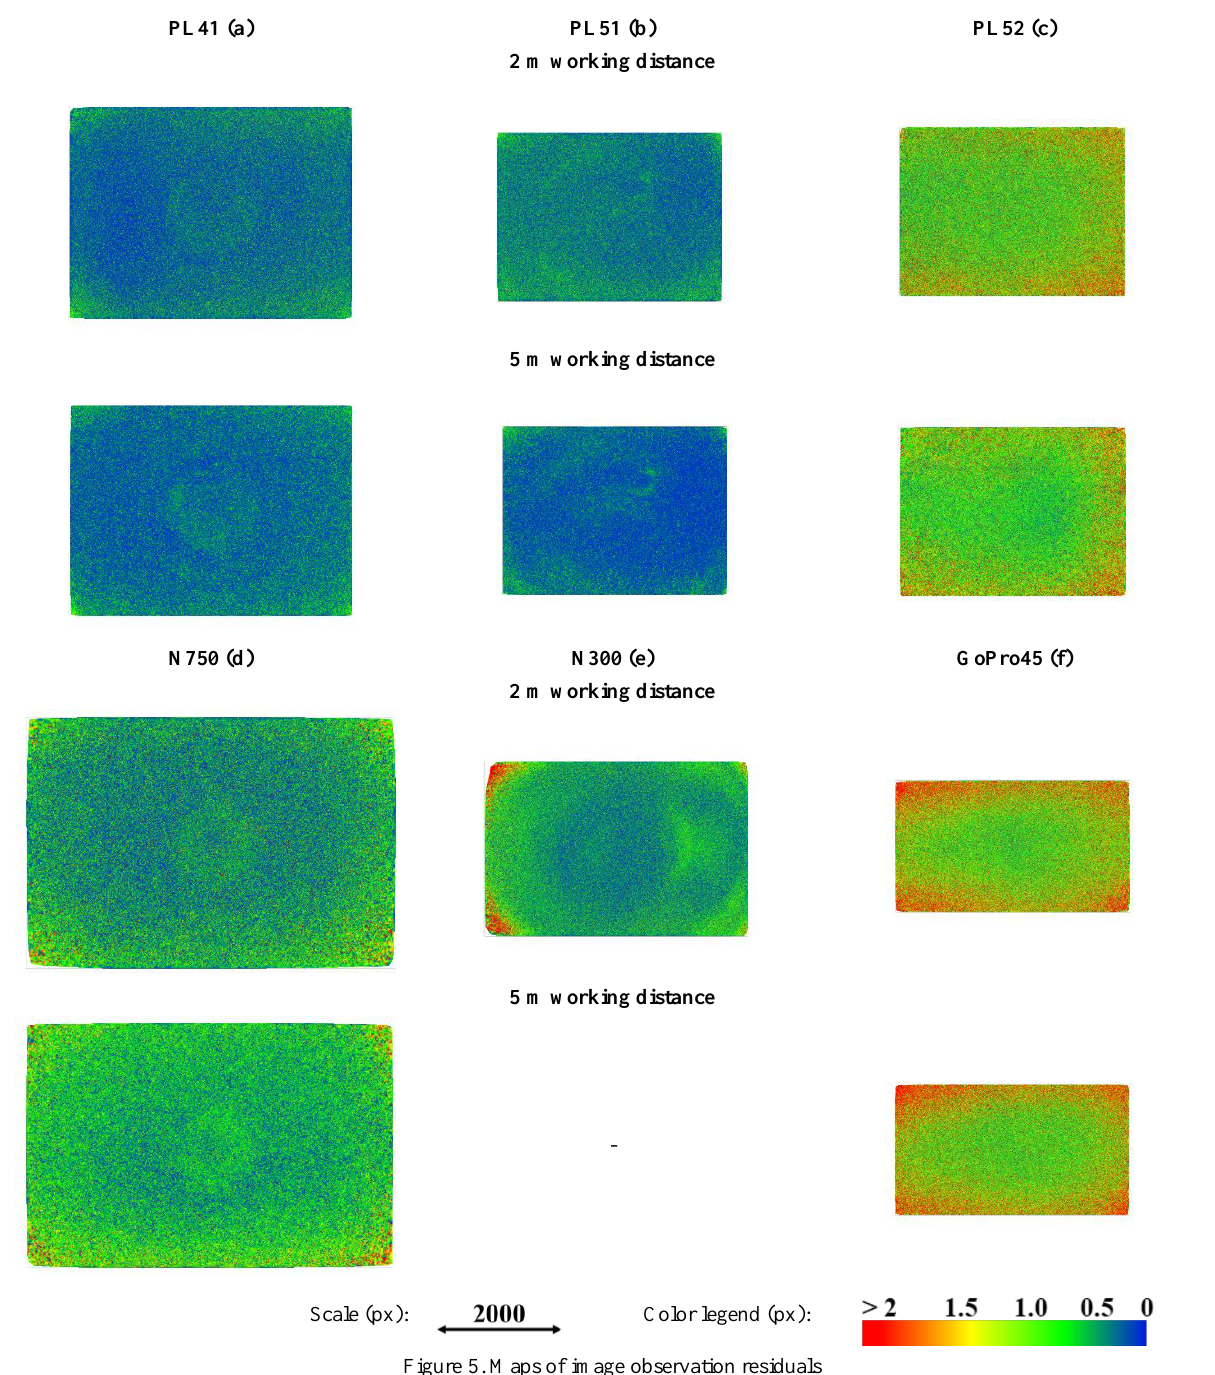
Figure 5. Maps of image observation